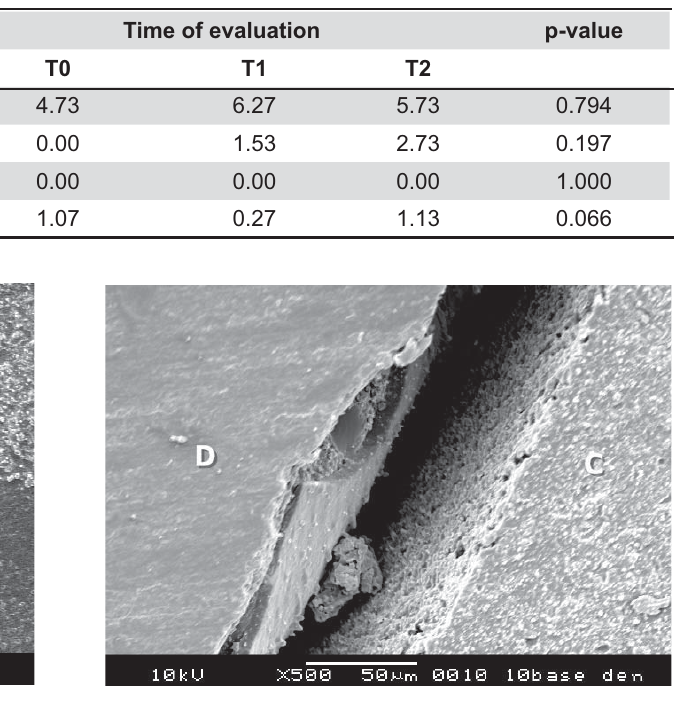
Figure 2- Intact margin in enamel obtained with Single Bond 2 after thermo-cycling (T1). E – Enamel; C – Composite